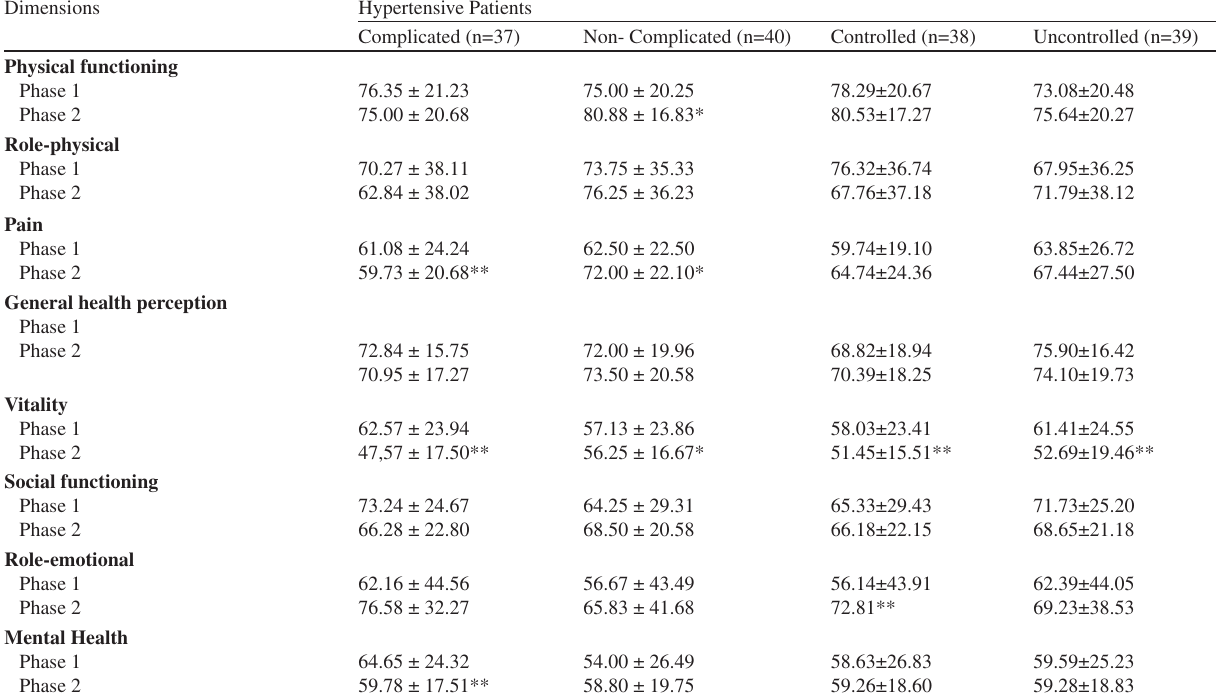
Table 3 - Health-related quality of life scores by SF-36 dimensions.